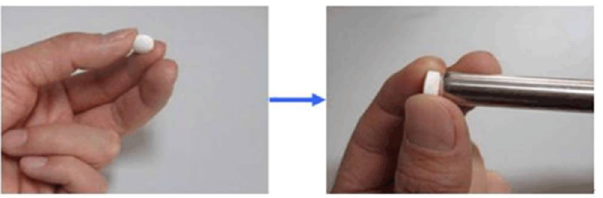
Figure 1. Operation method for spectrometric measurement of ordinary tablets.